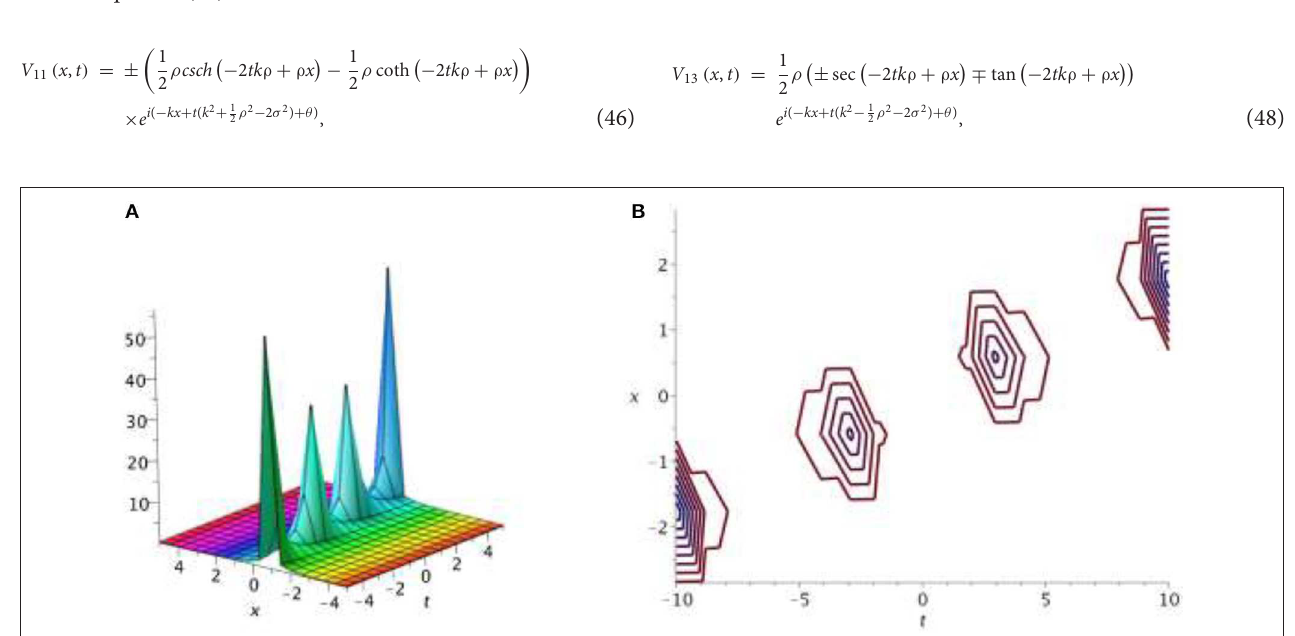
FIGURE 4 | (A) Combined singular solution Equation (47). (B) Contour plot.